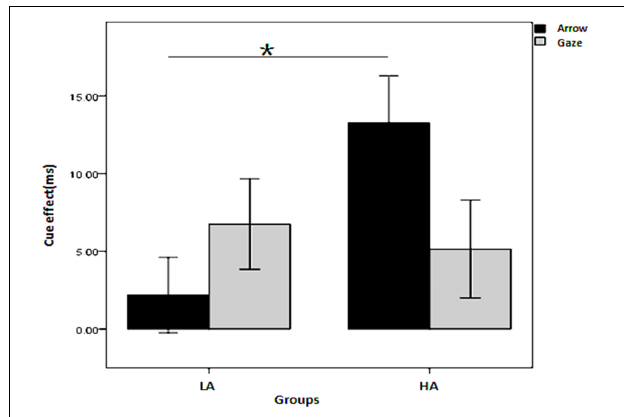
FIGURE 3 | Interaction between group and cue type on the cue effect in the non-predictive condition. *Indicates significant difference between the two conditions.